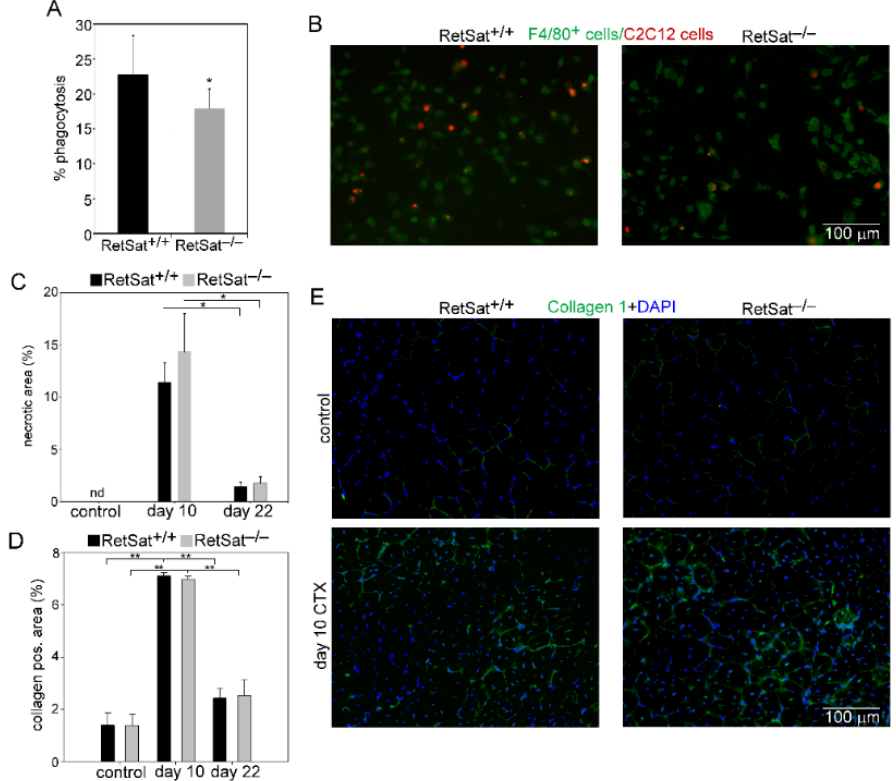
Figure 3. Unaltered necrotic cell removal and collagen deposition in the TA muscles of RetSat-null mice following CTX-induced damage. Decreased in vitro phagocytosis of necrotic C2C12 myoblasts by muscle-derived RetSat − / − F4/80 + cells determined ( A ) by FACS analysis and ( B ) by visualizing the number of engulfed cells. ( C ) Necrotic regions in the control and regenerating muscles of RetSat +/+ and RetSat − / − mice at days 0, 10, and 22 post-CTX injury. ( D ) Quantification of collagen 1-positive regions in control and 10- and 22-day regenerating muscles of RetSat +/+ and RetSat − / − mice. ( E ) Representative immunofluorescence pictures of type 1 collagen (green) and DAPI (blue) nuclear staining in control and 10-day regenerating TA muscles of RetSat +/+ and RetSat − / − mice. Scale bars, 100 μ m. All data are expressed as mean ± SD ( n = 4). Asterisks indicate statistical significance (* p < 0.05, ** p < 0.01); nd, not detected.